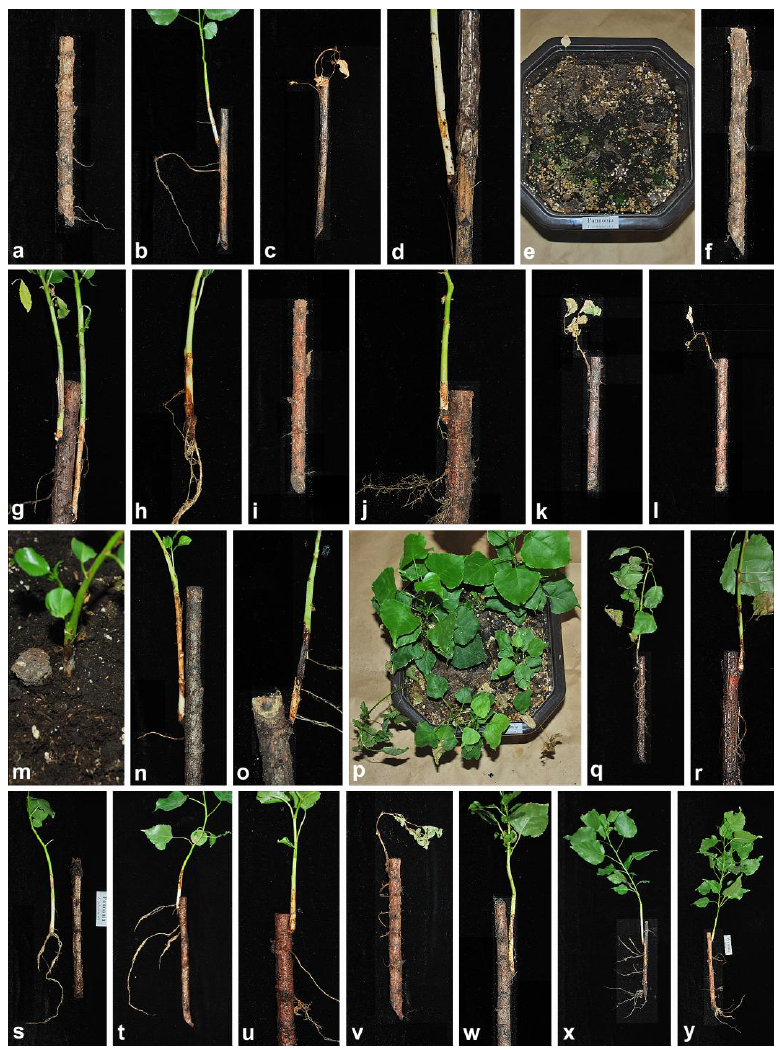
Figure 3. Representative cuttings of poplar clone P á nnonia after ten weeks in soil infested with nine Phytophthora spp.: ( a , b ) P. cactorum ; ( c , d ) P. cryptogea ; ( e , f ) P. gonapodyides ; ( g , h ) P. lacustris ; ( i , j ) P. pini KF234655; ( k , l ) P. pini KF234658; ( m , o ) P. plurivora KF234737; ( p , r ) P. plurivora KF234740; ( s ) P. polonica JX276065; ( t ) P. polonica KF234760; ( u , v ) P. × cambivora ; ( w ) P. × serendipita ; ( x , y )